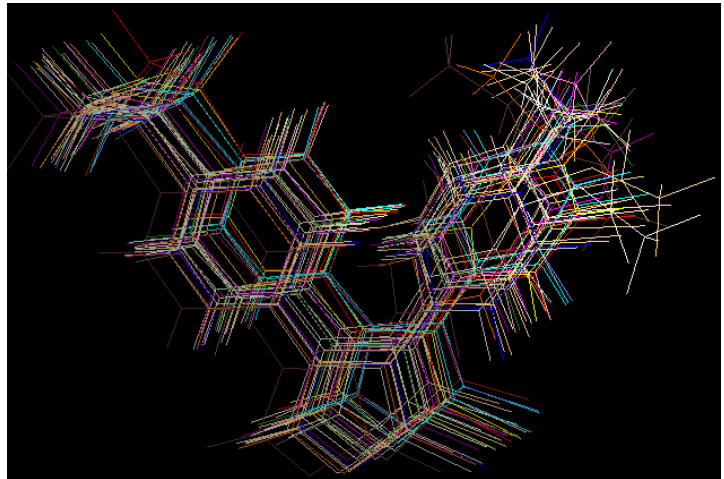
Figure 2. Superposition of 1,5-Diarylimidazoles structures after docking